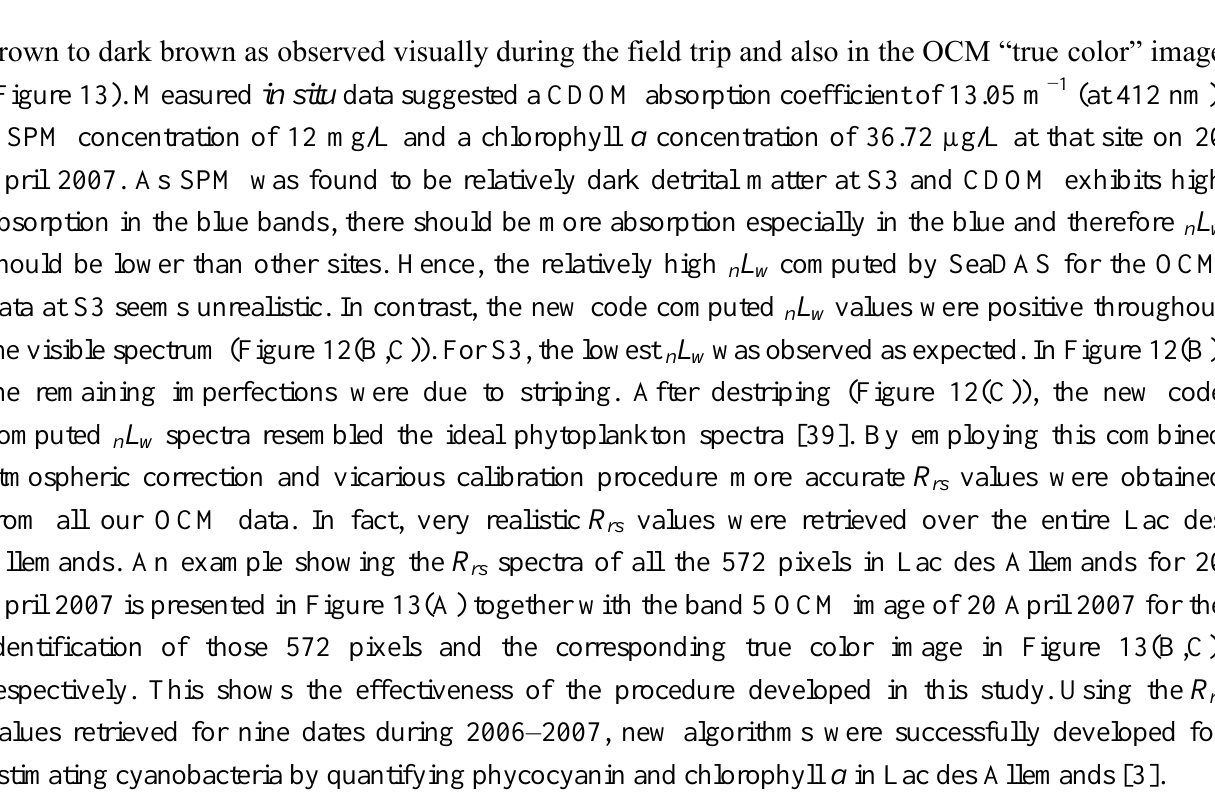
L ) calculated by SeaDAS n w